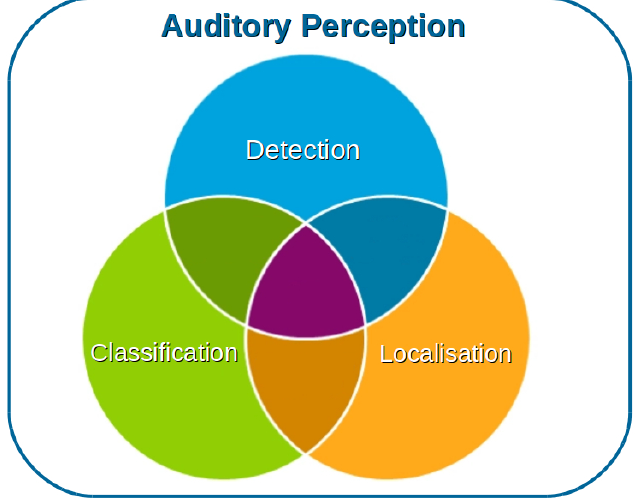
Figure 2. Objectives for which auditory perception is carried out, namely: detection (whether a sound of interest exists or not), classification (what produced the sound), and localization (where the sound